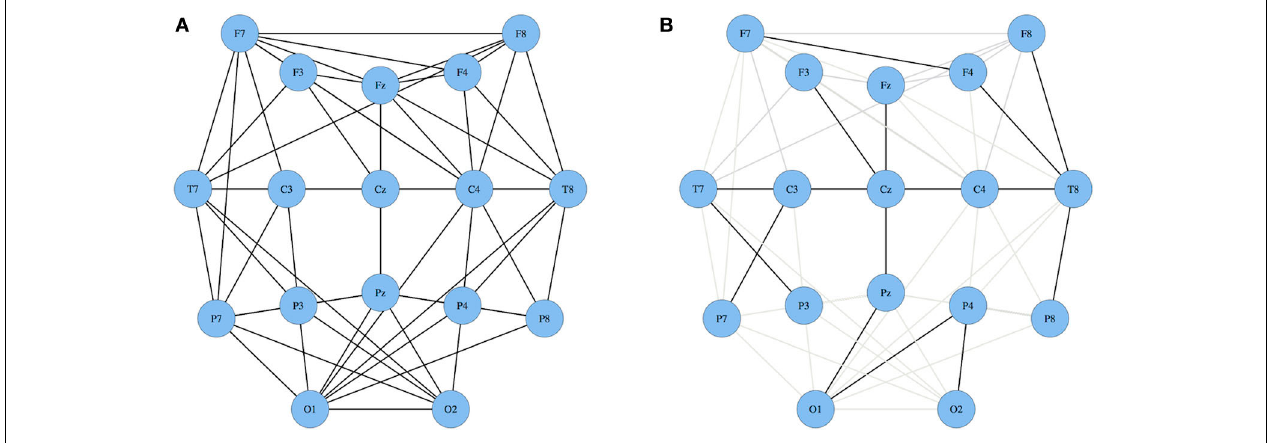
FIGURE 1 | Two schematic illustrations of networks. (A) a standard network and (B) a MST network wherein all nodes are connected only once resulting in a loopless network. In panel (B)